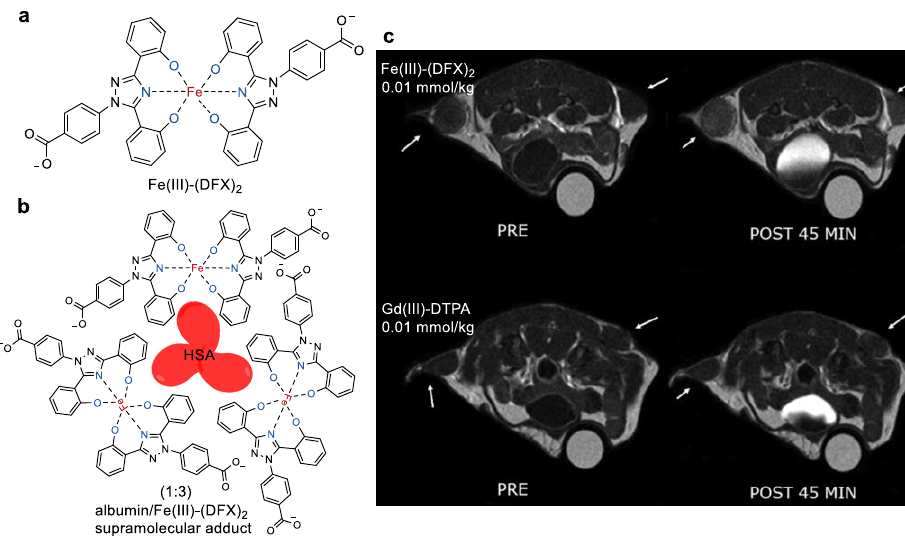
Figure 4. ( a ) Chemical structures of Fe(III)–(DFX) 2 , ( b ) albumin/Fe(III)–(DFX) 2 supramolecular adduct, and ( c ) T 1-weighted images of the TS/A-inoculated mouse with or without administration of Fe(III)–(DFX) 2 and Gd(III)–DTPA [39]. The arrows indicate the tumor regions. Reprinted/adapted with permission from Ref. [39]. Copyright 2021 American Chemical Society.